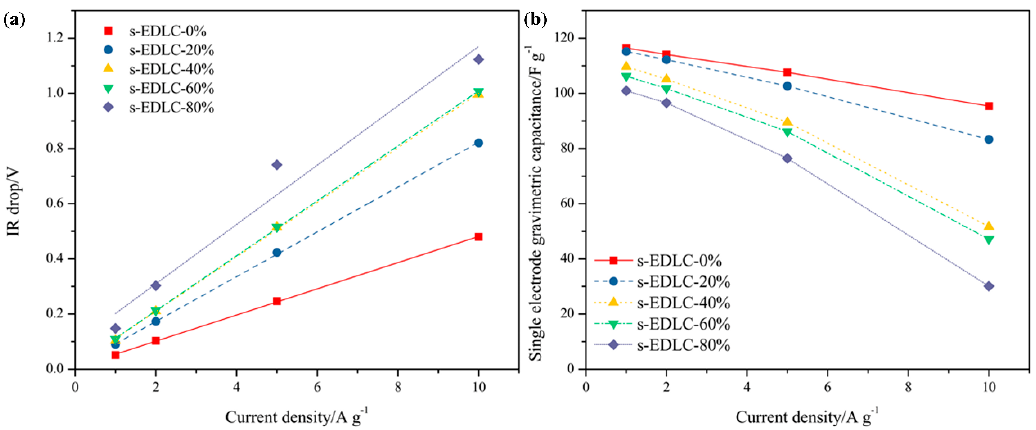
Figure 7. IR drops ( a ) and single electrode gravimetric capacitances ( b ) of the solid-state supercapacitors at various current densities.